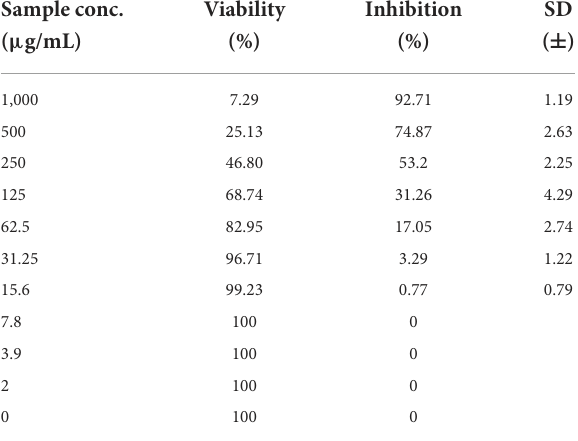
TABLE 3 Cytotoxic activity of a chitosan-propolis nanoparticle mixture in mammalian cells derived from African Green Monkey kidney (Vero) cells at a 50% cell cytotoxic concentration. Sample